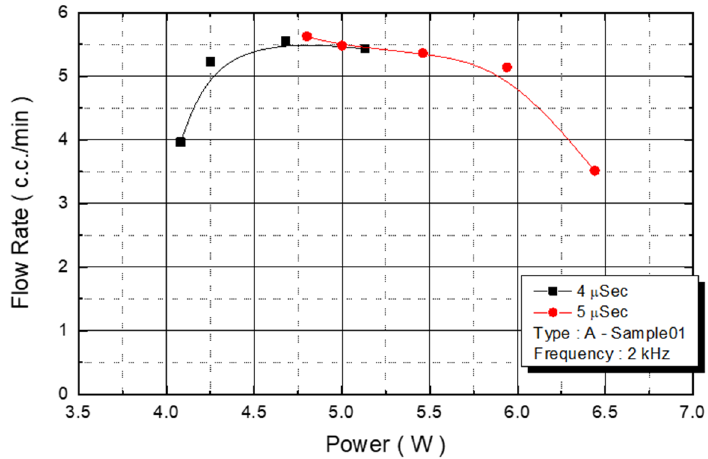
Figure 12. A Type-Sample01 flow rate.